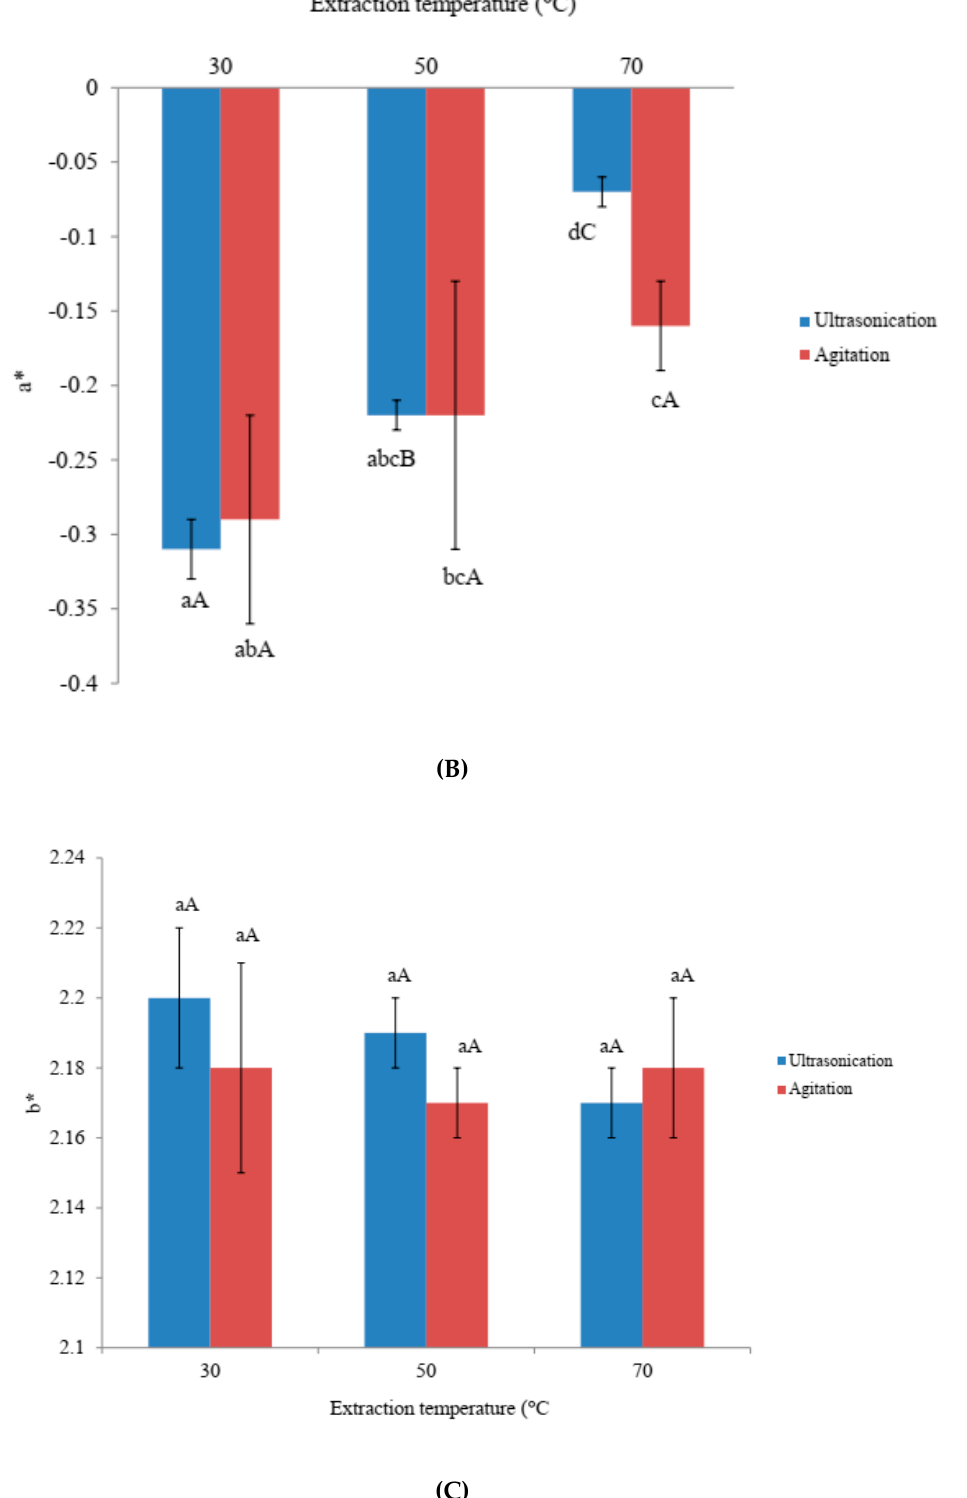
Figure 1. E ff ects of ultra-sonication and agitation on color values of amaranth extract. ( A ) L* values ( B ) a* values ( C ) b* values. a–d Means with same subscript alphabets are not significantly di ff erent ( p ≤ 0.05) between each extraction method. A–C Means with same subscript alphabets are not significantly di ff erent ( p ≤ 0.05) among di ff erent temperatures in each extraction method.